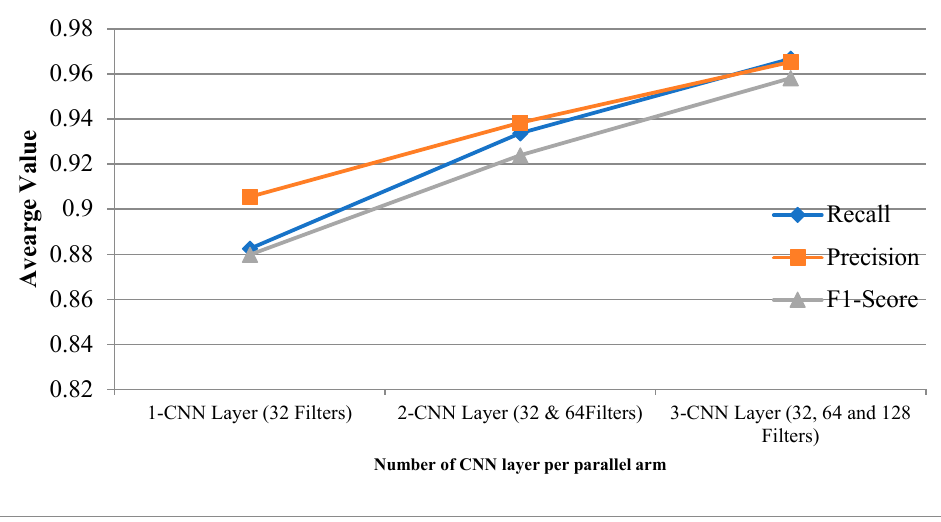
Figure 5. Recall, precision, and F1 score for proposed CPDCNN for various layers.